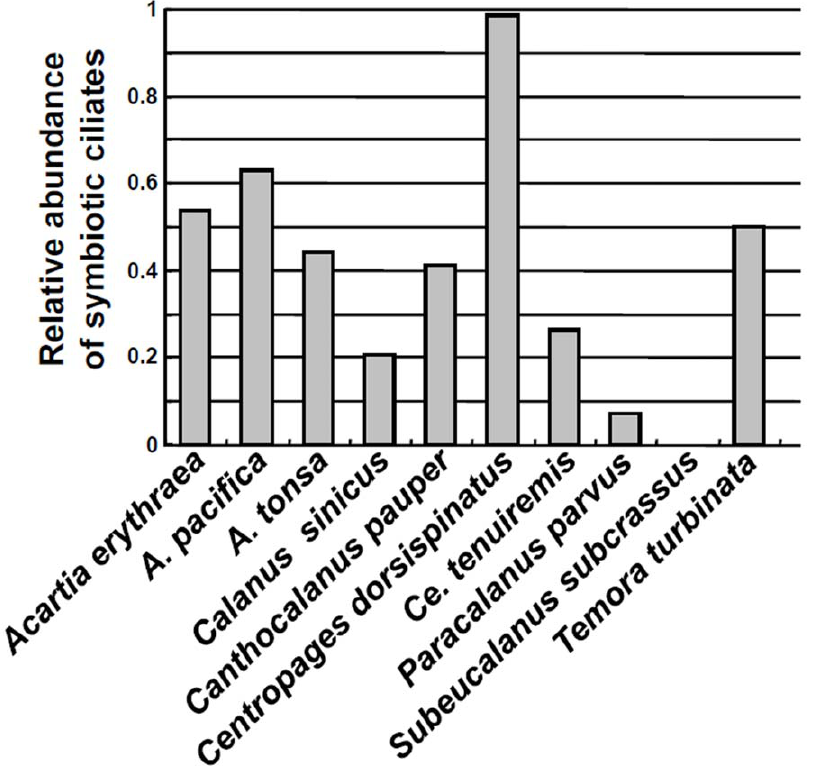
Figure 2. Ratio of symbiotic ciliate groups . Relative abundances of symbiotic ciliate (Apostomatida and related) 18S rDNA groups in all sequences obtained from the in situ fixed copepods ( Acartia erythraea , A. pacifica , A. tonsa , Calanus sinicus , Canthocalanus pauper , Centropages dorsispinatus , C. tenuiremis , Paracalanus parvus , Subeucalanus subcrassus , Temora turbinata ). doi:10.1371/journal.pone.0044847.g002 PLOS ONE |